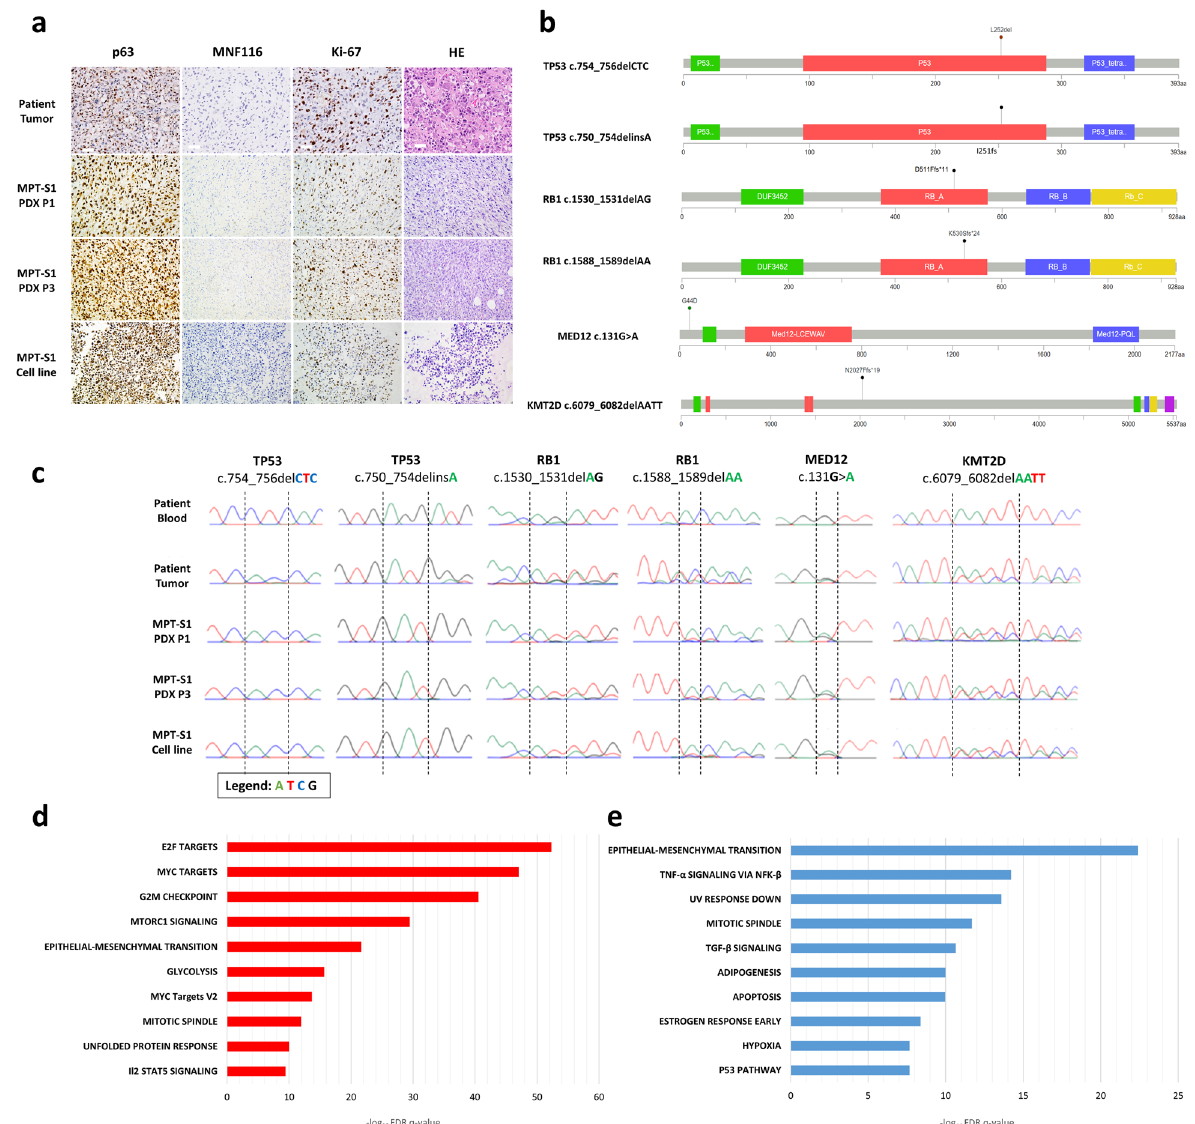
Fig. 2 Morphologic and genomic characterization of patient-derived xenograft (PDX) and cell line. a Immunohistochemistry (IHC) pro fi les of the PDX and cell line were positive for p63 and Ki-67 staining which were concordant with the patient ’ s original tumor sample (scale bar: 50 µm). b Somatic mutations in MED12 , TP53 , RB1 , and KMT2D identi fi ed on whole exome sequencing and ( c ) veri fi ed on Sanger sequencing. Whole transcriptomic sequencing and gene set enrichment analysis identi fi ed signi fi cant ( d ) upregulated and ( e ) downregulated pathways within the tumor as compared to matched normal